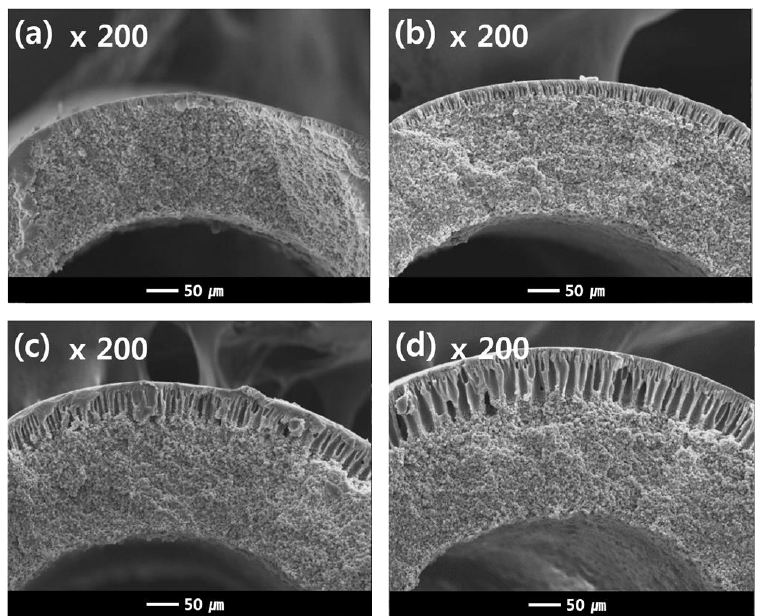
Figure 12. Cross-sectional SEM images of the dual-layer hollow fibers (Sample #2N) as a function of NIPS extrusion rate. The NIPS extrusion rate is ( a ) 3 g/min ( b ) 5 g/min ( c ) 7 g/min and ( d ) 9 g/min, the TIPS extrusion rate is 17 g/min, and the bore extrusion rate is 6 g/min.